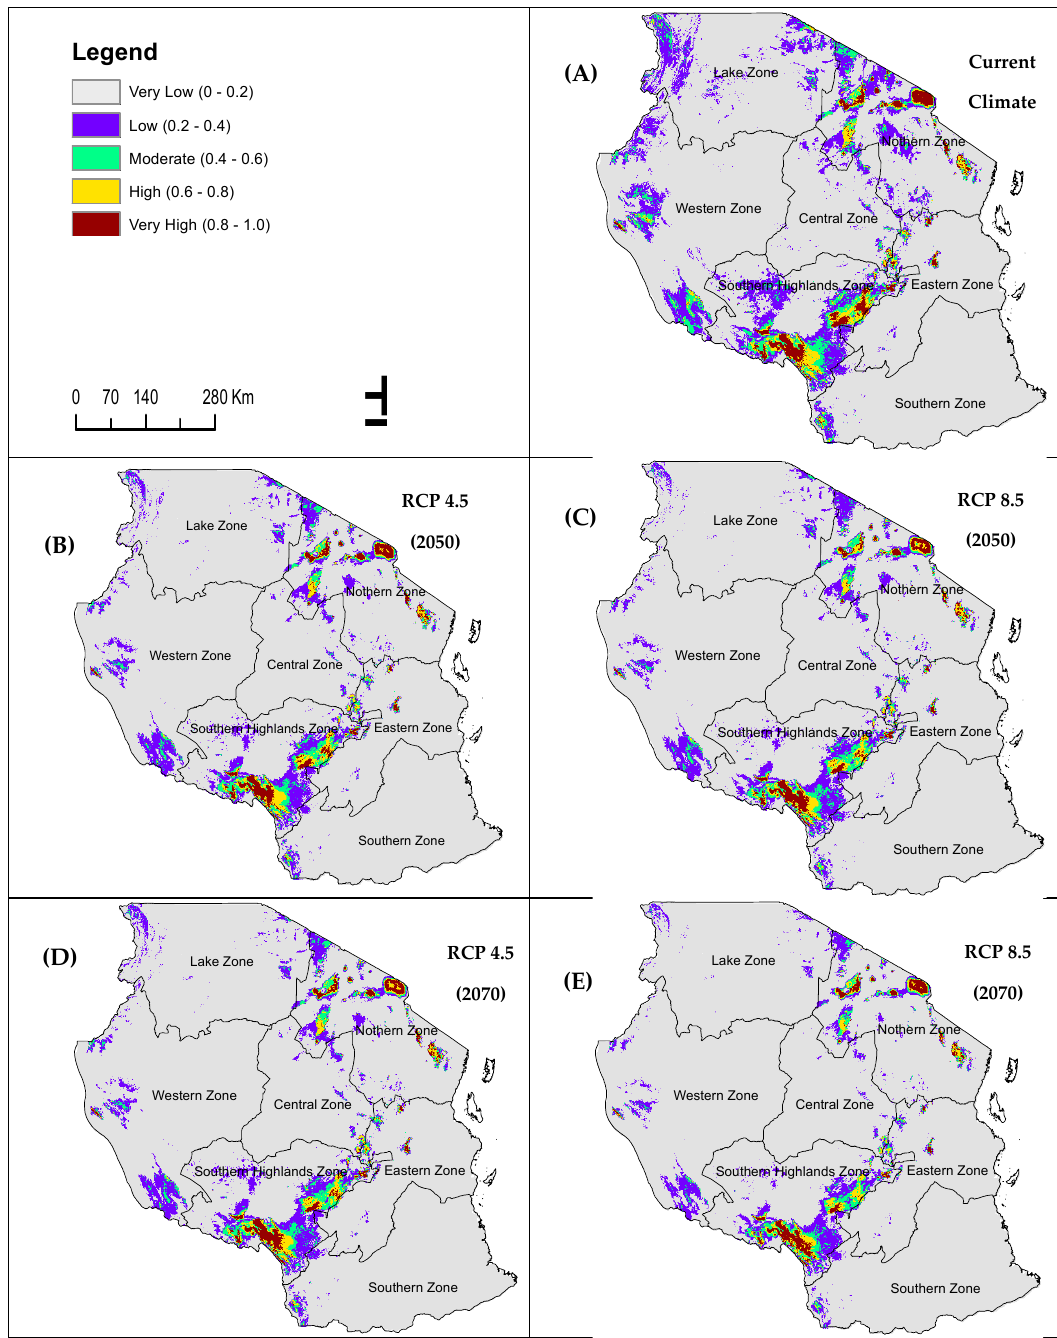
Figure 4. Climate Community Climate System version four (CCSM4) climate model based predicted future suitability of P. africana species: ( A ) current potential distribution; ( B , C ) RCP 4.5, and 8.5 emission scenario for 2050; ( E , D ) RCP 4.5, and 8.5 scenario for 2070.